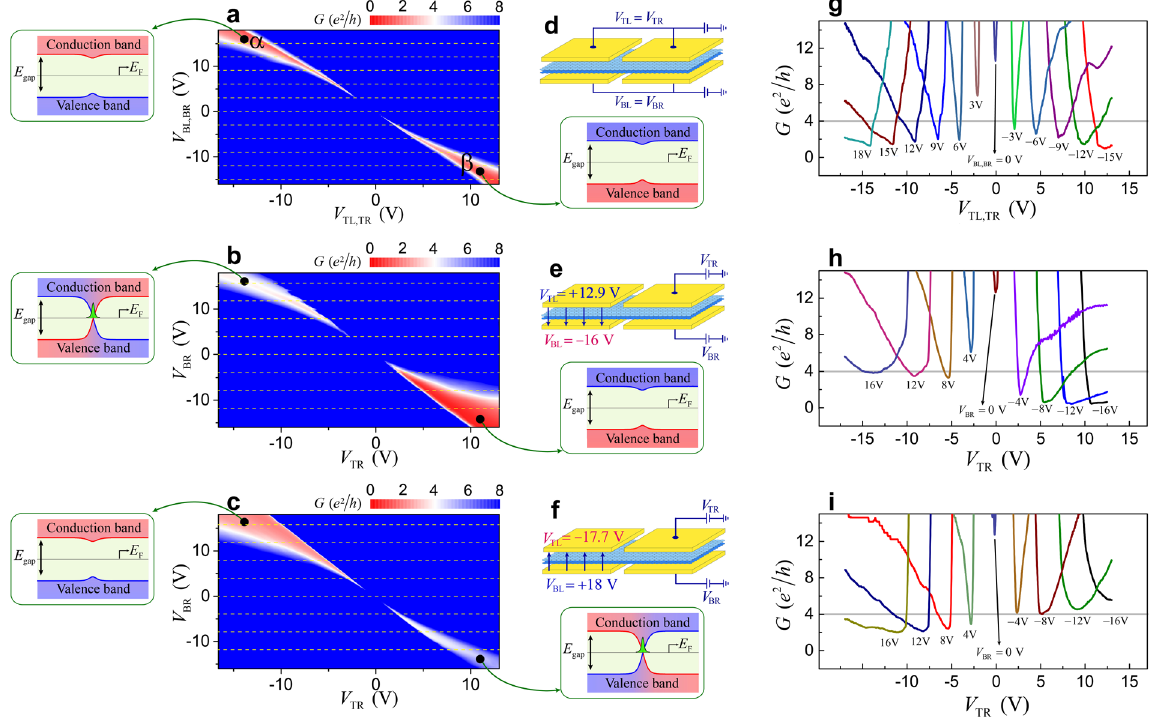
Figure 2. Symmetric- and asymmetric-gate configurations. ( a ) V TL,TR and V BL,BR ( b , c ) ( V TR and V BR ) dependence of the conductance ( G ) in coded colours. The white conductance region corresponds to the value of G = 4 e 2 / h . Each rounded box illustrates the band gap profile of the corresponding conductance region along the dotted line in the region I in Fig. 1d. ( d – f ) Schematic measurement configuration. ( g – i ) Slice traces corresponding to dashed lines in the conductance maps in a – c . The horizontal solid lines are the quantum conductance of G = 4 e 2 / h